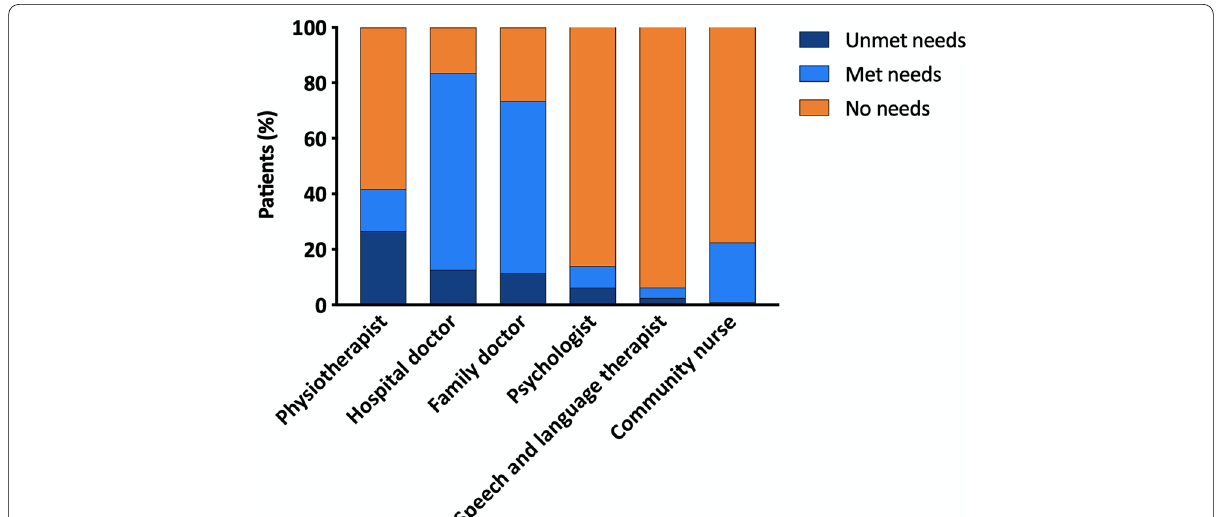
Fig. 5 Description and distribution of health professionals needs in C-ARDS